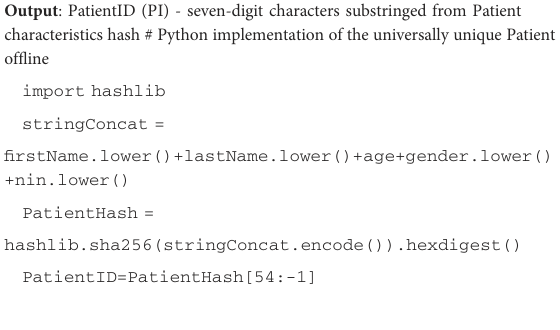
Algorithm 3: Algorithm for of fl ine generation of unique Patient ID (PI)